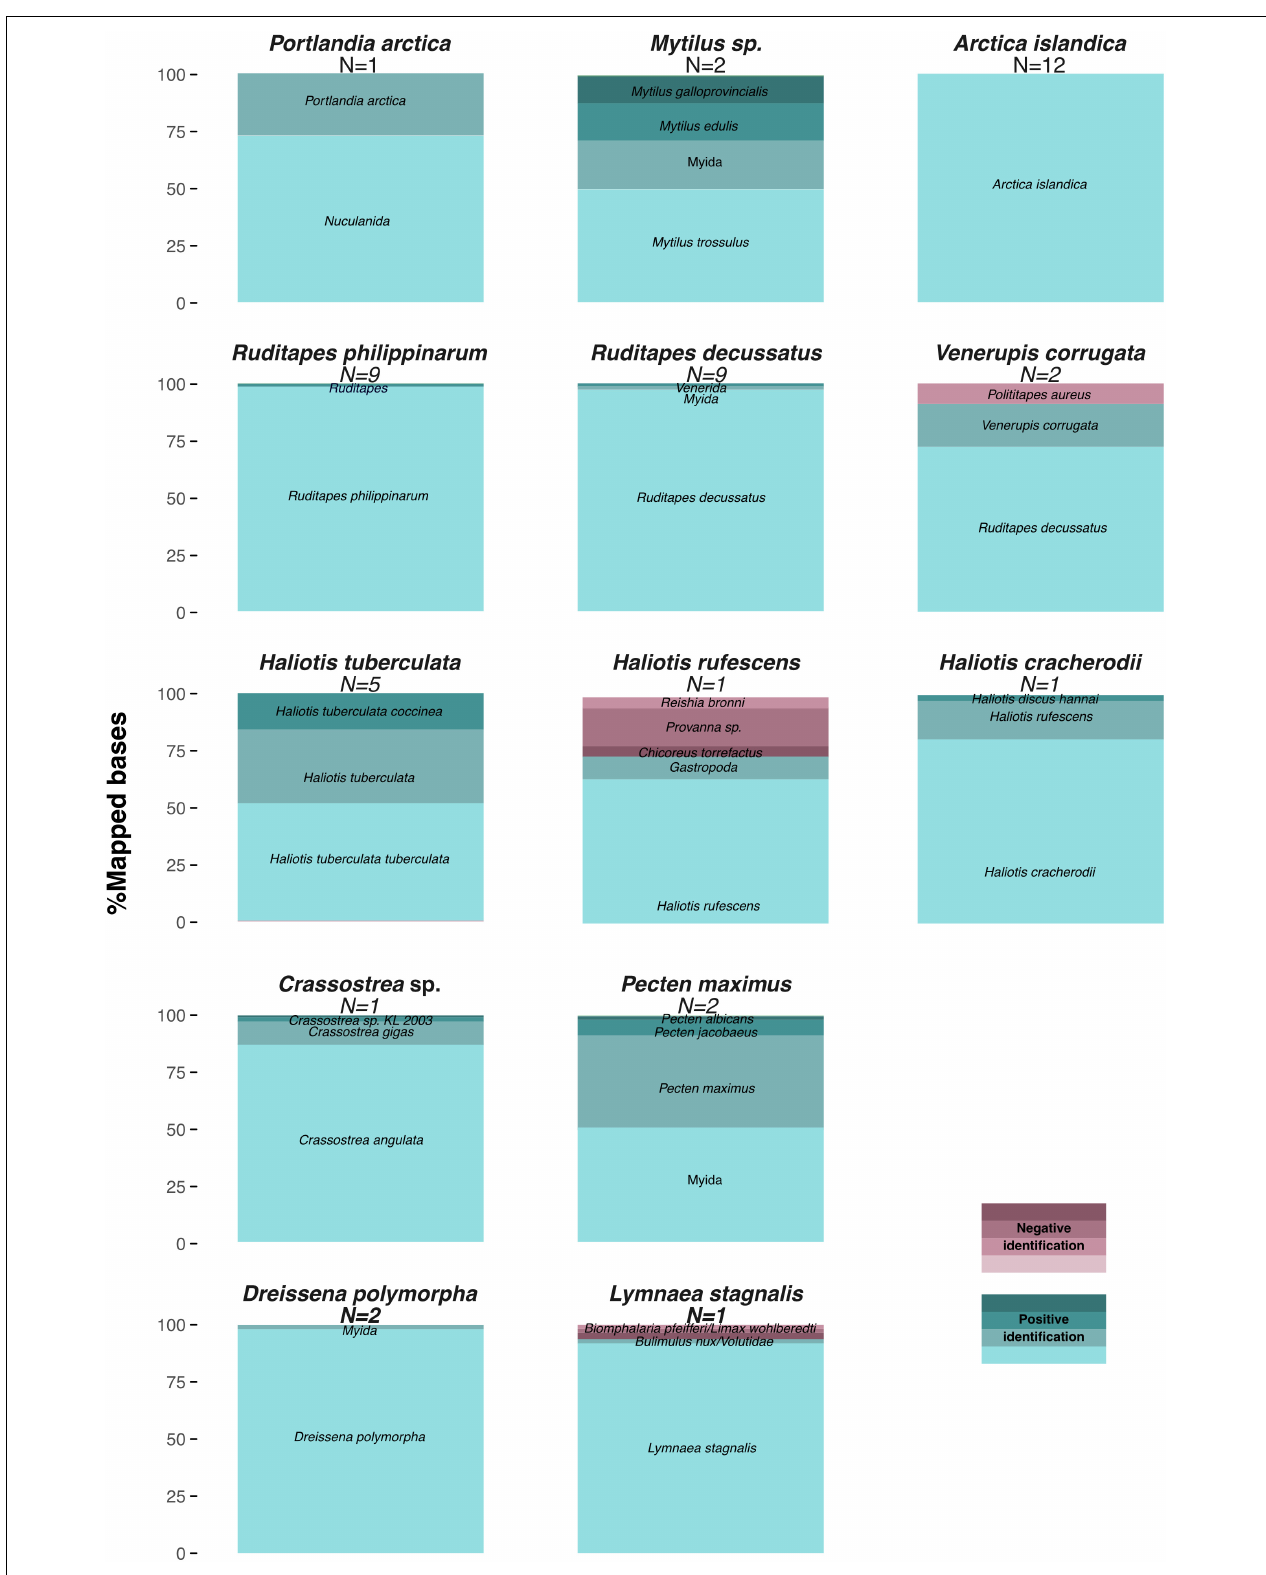
FIGURE 4 | COI-5P barcode-based identification of Mollusca taxa from shell DNA. Proportion of total nucleotides mapped to each reference marker combining all datasets for samples of the same genus and considering unique high quality ( ≥ 30) reads and reference markers covered by ≥ 150 bp ( Supplementary Table S4 ).